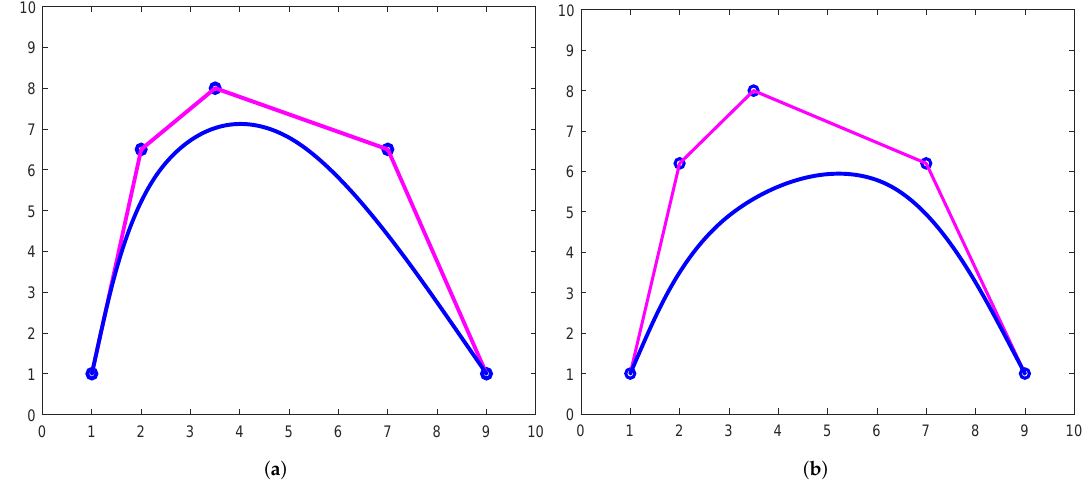
Figure 14. Cubic rational B-spline curve. ( a ) Effect of control points. ( b ) Effect of weights.